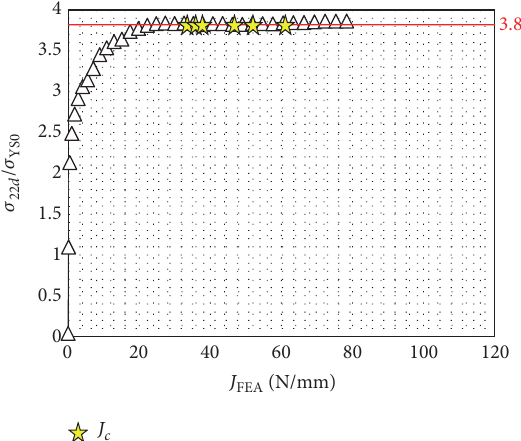
Figure 7: The relationship between 𝜎 22𝑑 and 𝐽 FEA of the 25t SE(B) specimen (S55C, 20 ∘ C): fracture always occurred after 𝜎 22𝑑 reached = 3.82𝜎 𝜎 22𝑐 YS 0